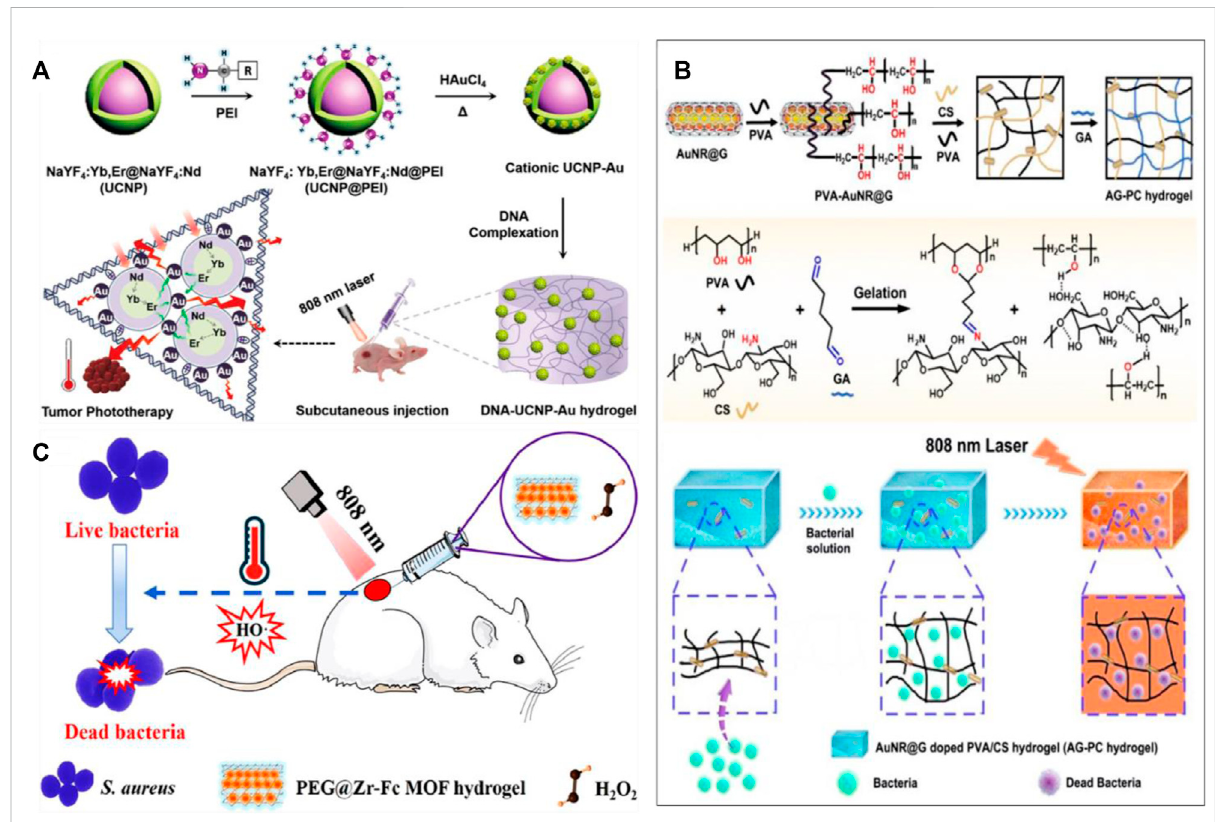
FIGURE 7 (A) Preparationandapplication ofDNA-inorganic hybridhydrogels. Reproducedfromref.47withpermissionfrom2020Wiley-VCHGmbH. (B) Schematic diagram of the procedure for preparation of AG-PC hydrogel and the suggested mechanism and its application in antimicrobial fi eld. Reproduced from ref. 91 with permission from 2019 Royal Society of Chemistry. (C) Diagram of the action mechanism of hybrid hydrogels. Reproduced from ref. 79 with permission from Acta Materialia Inc. Published by Elsevier